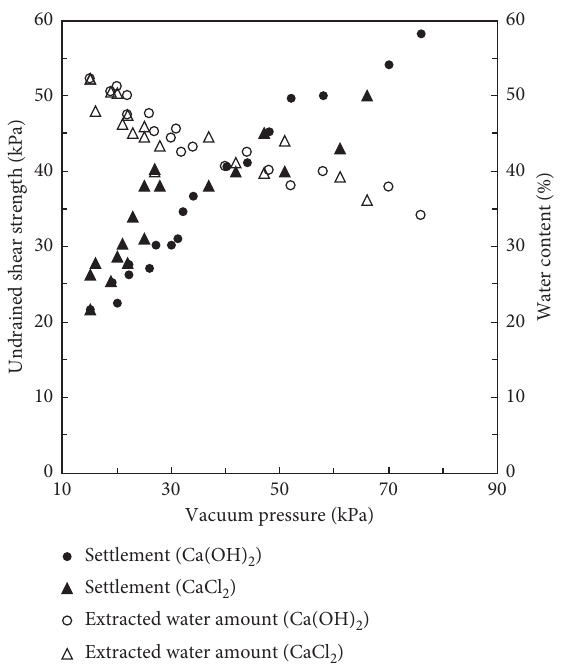
Figure 12: Relationship between vacuum pressure and water content/undrained shear strength after vacuum preloading